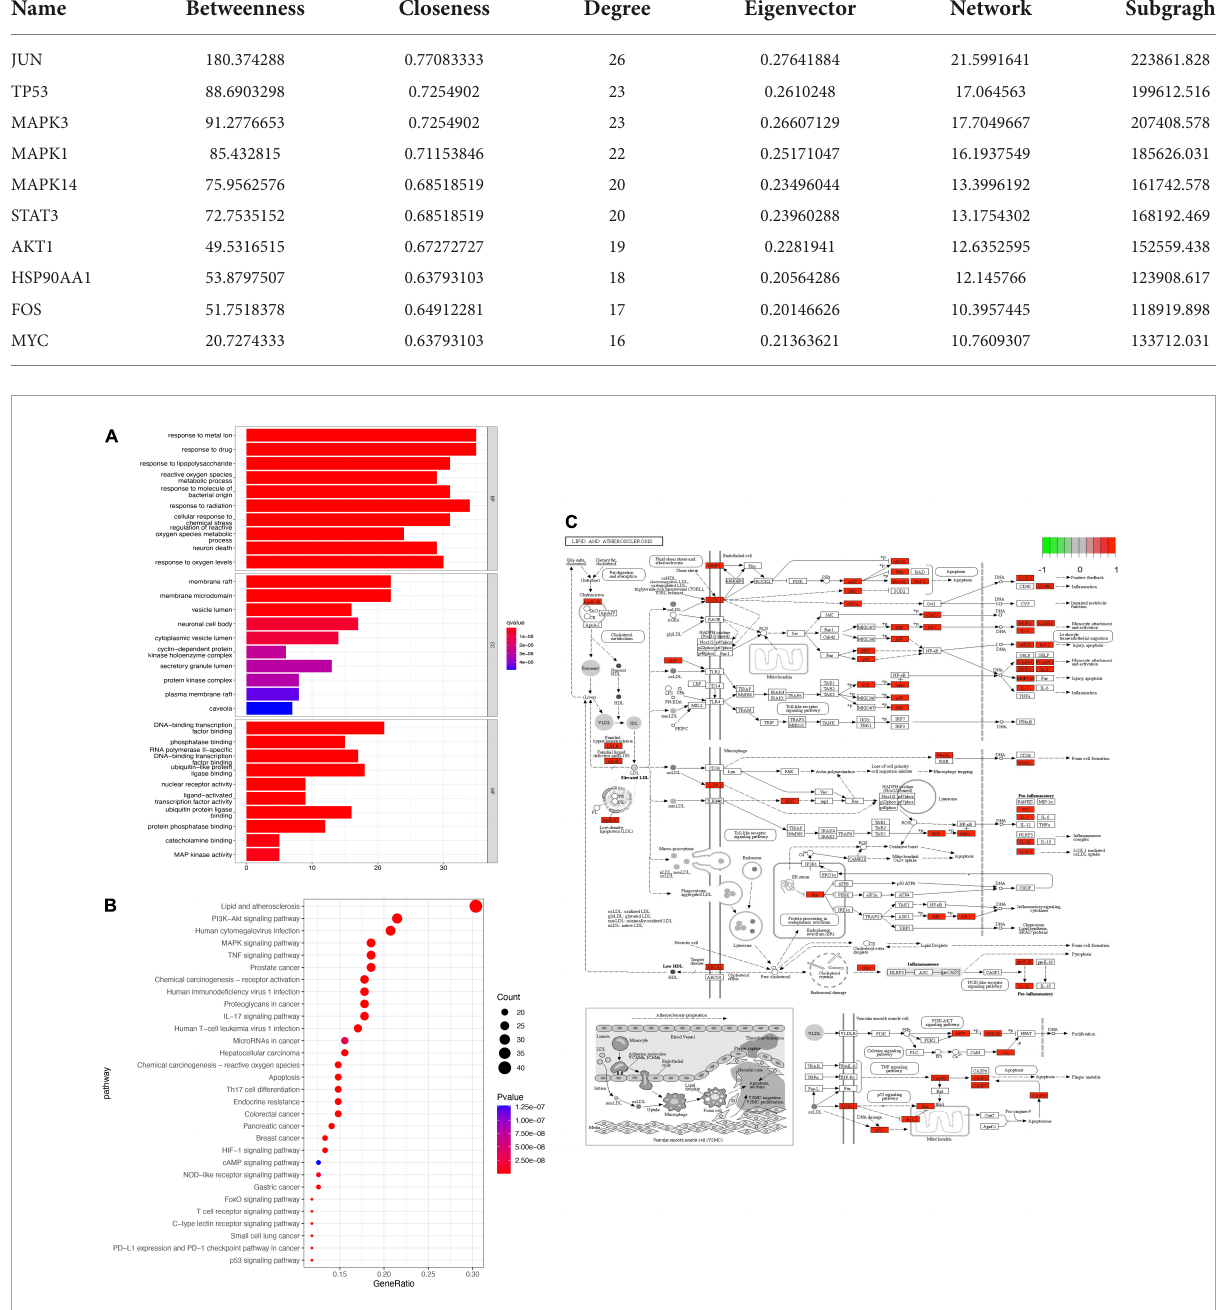
FIGURE4 Enrichment analysis. (A) GO enrichment analysis. (B) KEGG enrichment analysis. (C) The most enriched KEGG pathway. Red genes in the network is the SLD target